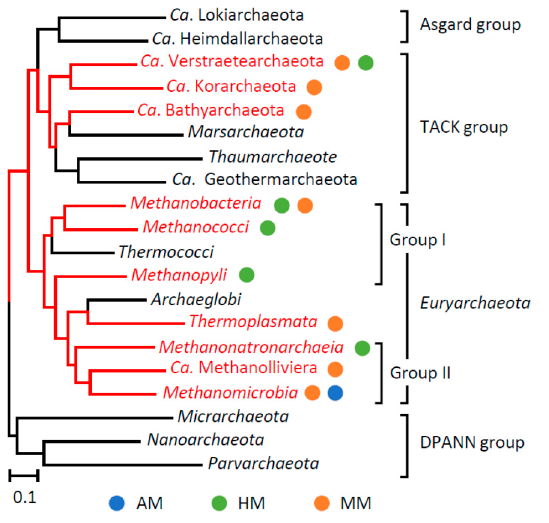
Figure 2. A phylogeny tree showing relationships among class-level phylogenetic groups in the domain Archaea, in which lineages that include methanogens are indicated in red. Circles with different colors indicate types of methanogens. The tree was constructed using the maximum- likelihood algorithm based on amino acid sequences of concatenated ribosomal proteins. AM, actoclastic methanogen; HM, hydrogenotrophic methanogen; MM, methylotrophic methanogen.